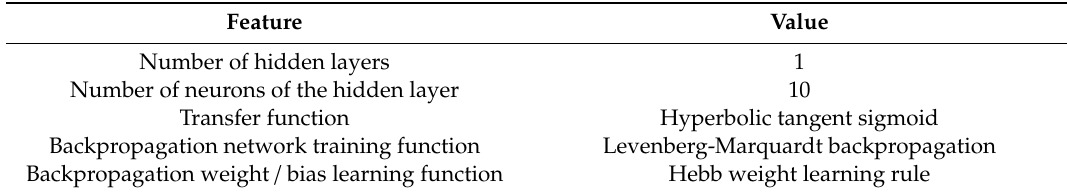
Table 2. Parameters of the ANN used in the ANN-PSO process to select the most e ff ective features.